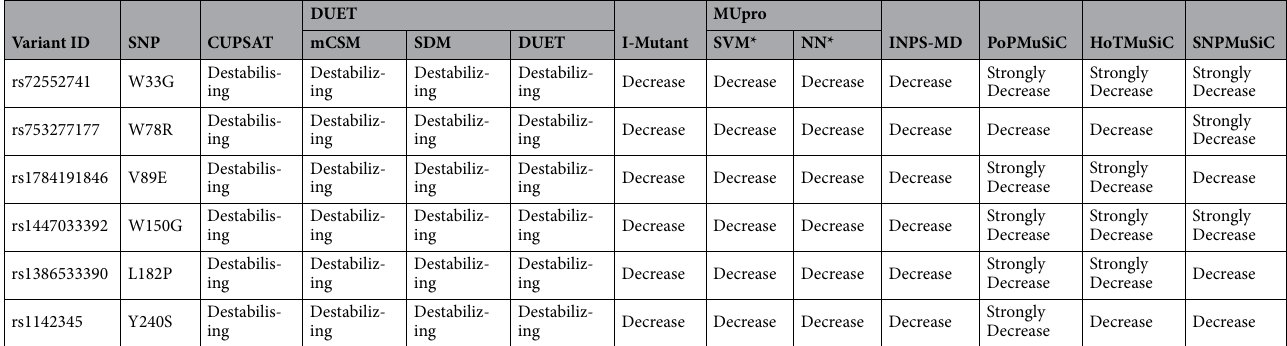
Table 2. List of missense nsSNPs predicted to be deleterious by at least six out of eight structure-based tools (As Y240S has already been identified to be deleterious, it is not a novel deleterious SNP and hence, it was